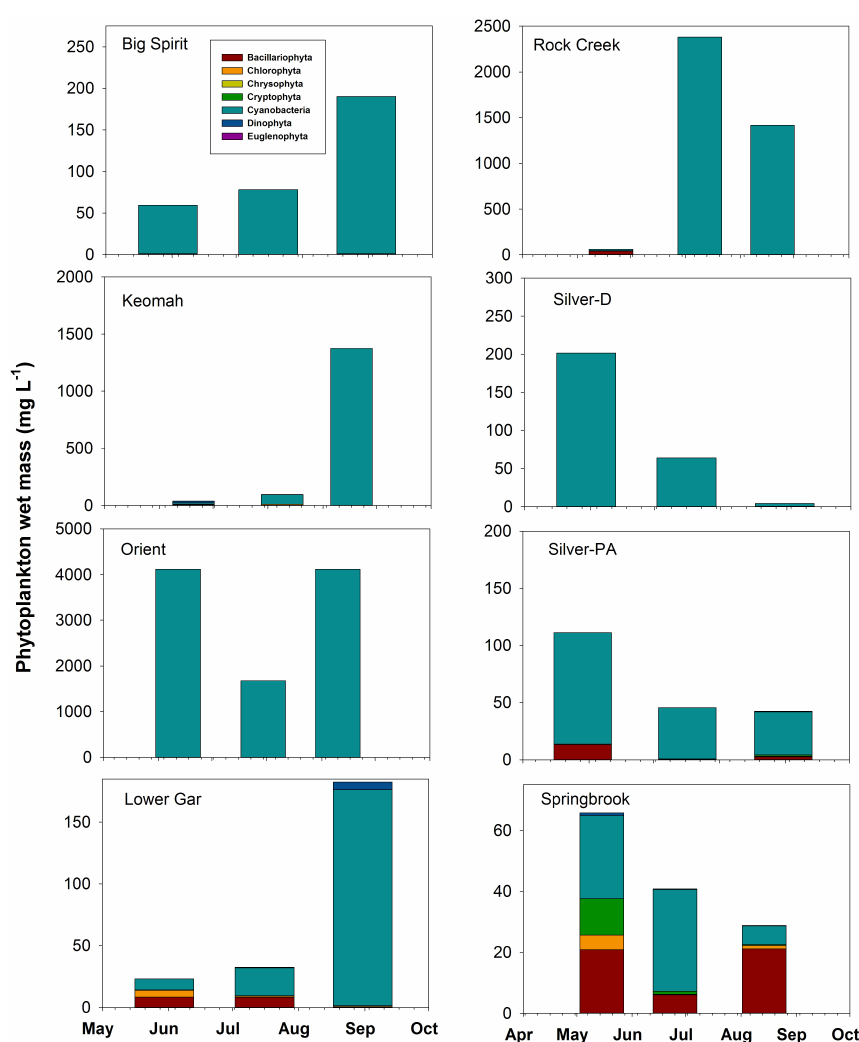
Figure 2. Community composition (division level) and biomass for three summer sampling points in the remaining 8 of 16